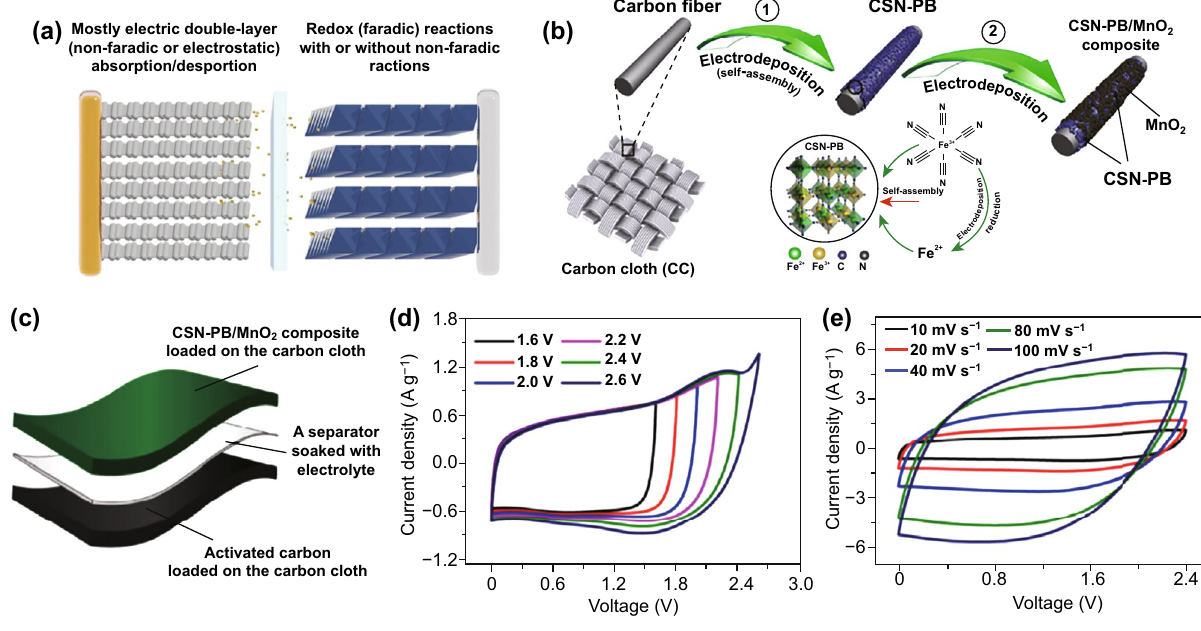
Fig. 9 a Schematic of an ASC device. Adapted with permission from Ref. [50]. b Schematic illustration of the CSN‑PB/MnO 2 //AC device con‑ figuration. c CV curves of the CSN‑PB/MnO 2 //AC device in different potential range at a scan rate of 10 mV s −1 . d CV curves of the CSN‑PB/ MnO 2 //AC device at varied scan rates from 10 to 100 mV s −1 in a potential range of 0–2.4 V. e CV curves of the CSN‑PB/MnO 2 //AC device at varied scan rates from 10 to 100 mV/s. Adapted with permissions from Ref.